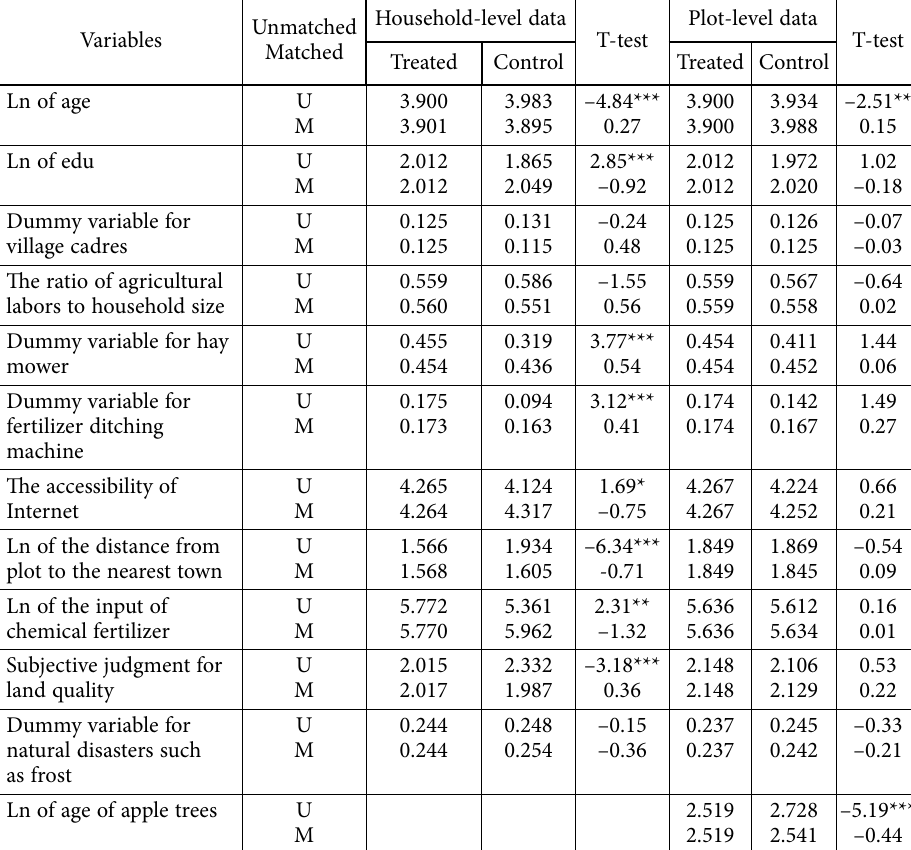
Table 6. Estimation results of the balance